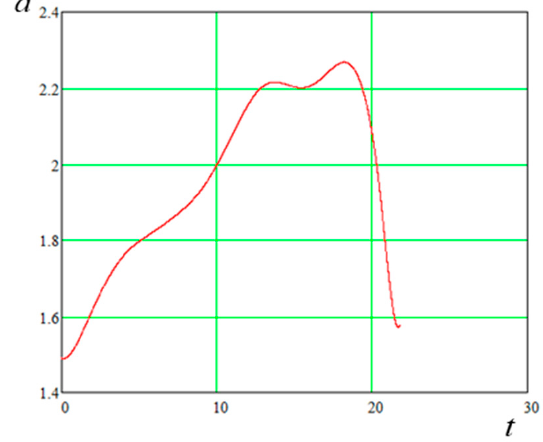
Figure 10. Plane of changing the parameters “Eccentricity—semi-major axis” [undim.]. Figure 10 shows a dependence typical of low-energy trajectories plotted on the “ec- centricity-major axis” plane; according to which there is an “exchange” of the eccentricity value for the value of the semi-major axis; at the same time, by the end of the transfer orbit, there is practically no secular deviation of the semi-major axis, which cannot be said about the eccentricity. Figure 11. Osculating argument for the perigee of a transfer orbit as a function of flight time [un- dim.].